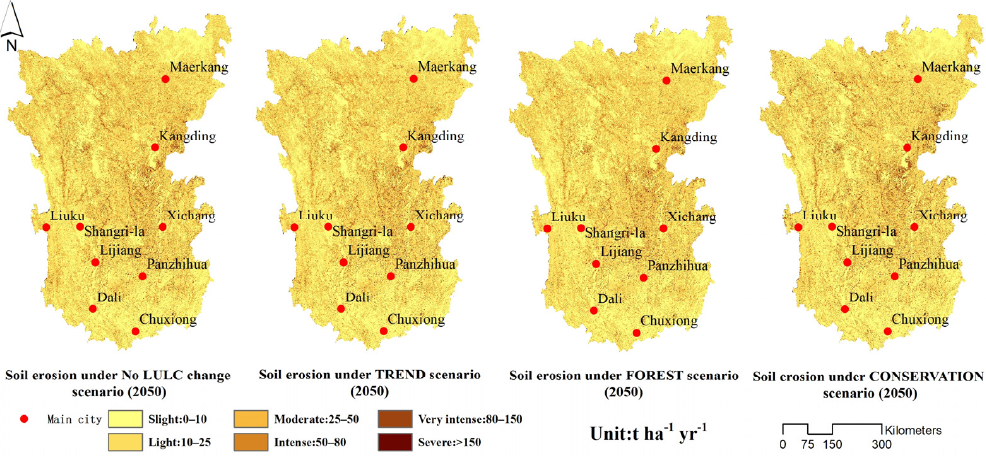
Figure 6. Spatial distribution of soil erosion under different scenarios (2050).